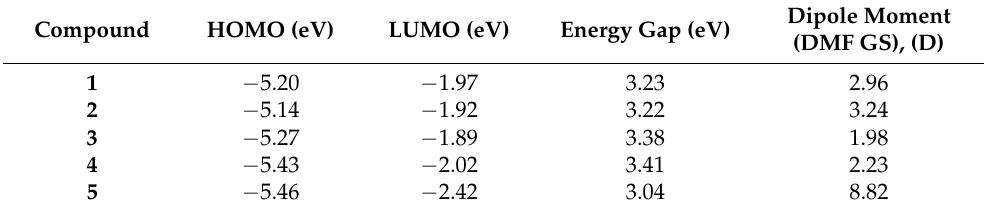
Table 1. Theoretical Energies and Dipole Moments of 1 – 5 in DMF (polar) a . Compound